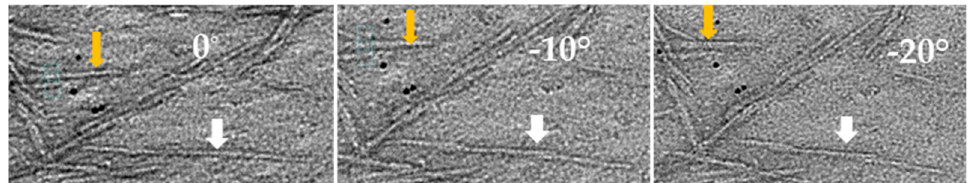
Figure 9. The end-to-end arranged CNC particles is shown as one particle in BF-TEM ( Left ); as two